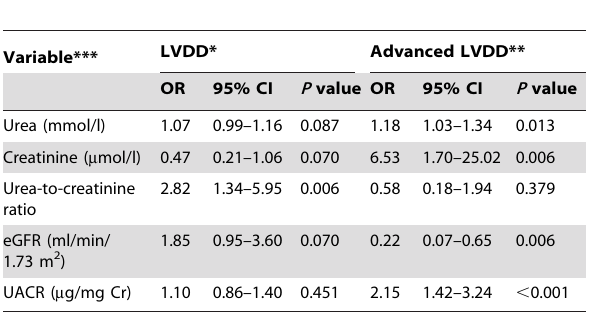
Table 4. The association of renal parameters with LVDD in subpopulation with eGFR . 60 ml/min/1.73 m . 2